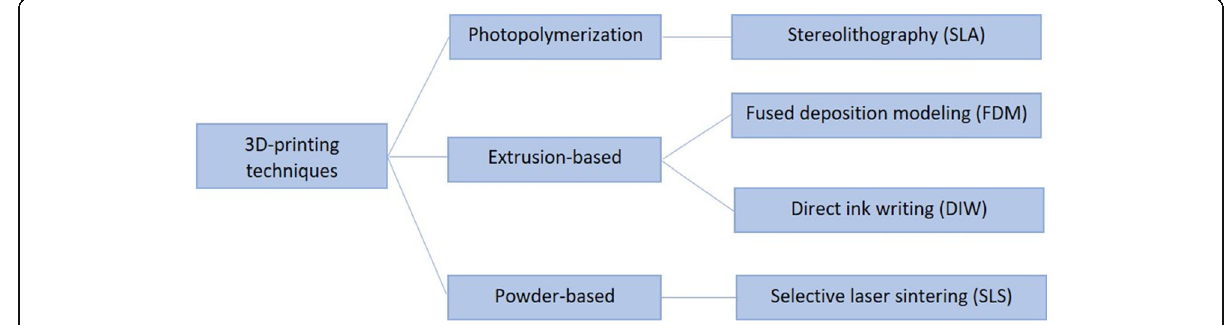
Fig. 2 3D Printing techniques used for graphene-based composites. Adapted from